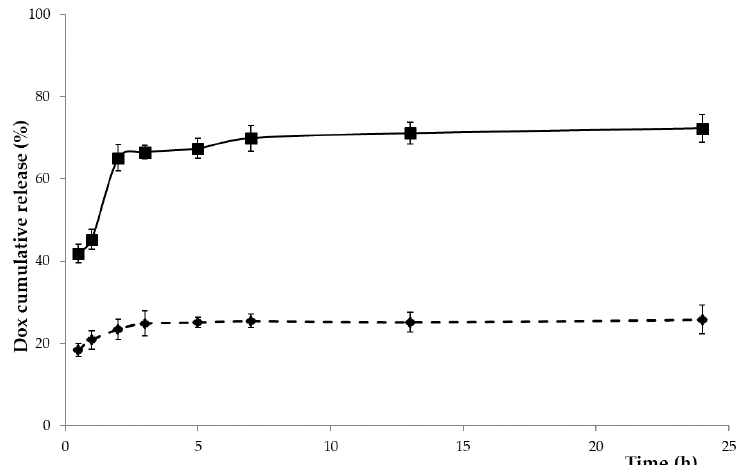
Figure 5. Drug release profiles of doxorubicin hydrochloride (DOX) from DOX@HNPs in phosphate buffer at pH 7.4 without (dashed line) and with glutathione (GSH) 10 mM (solid line) at 37 °C.